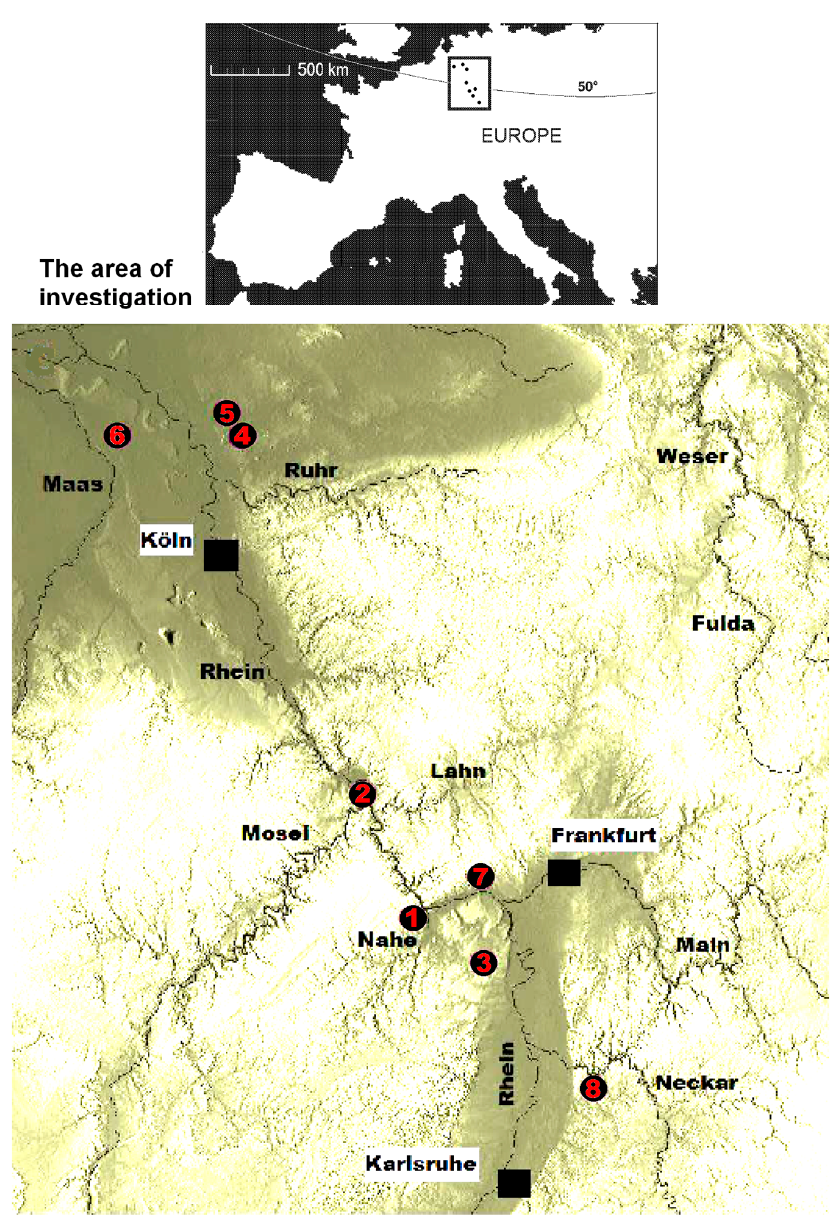
Figure 1. The geoposition of the northwestern European archaeological and / or paleontological sites dated in the Lower and Middle Pleistocene. 1. Münster-Sarmsheim, 2. Koblenz-Bisholder, Kärlich, Miesenheim, 3. Dorn-Dürkheim, 4. Kirchhellen, 5. Schermbeck, 6. Weeze, 7. Wiesbaden-Mosbach, 8. Mauer. (Graphics: G. Landeck)